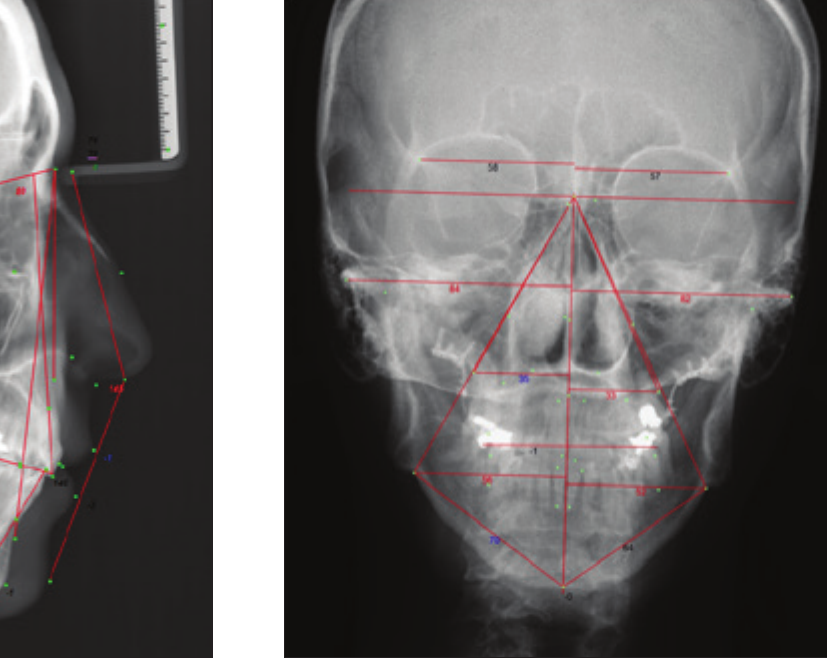
Figure 7. Post-treatment lateral cephalometric radiograph of the patient. Figure 8. Post-treatment posteroanterior radiograph of the patient. Table I. Pretreatment, post-treatment and 10 years follow-up lateral cephalometric